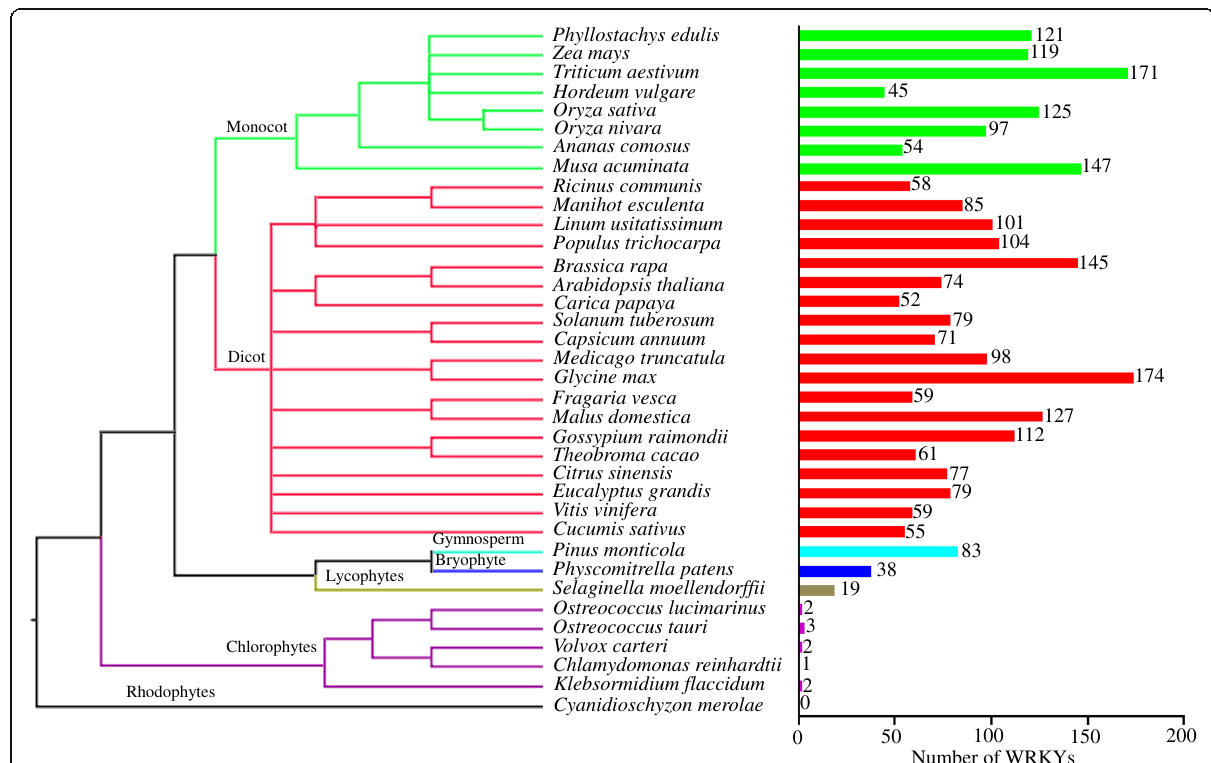
Fig. 2 Distribution of WRKY family genes in 36 plantae species. Phylogenetic tree was constructed based on NCBI taxonomy browser (https:// www.ncbi.nlm.nih.gov/Taxonomy/CommonTree/wwwcmt.cgi) and FigTree_v1.4.3 using Cyanidioschyzon merolae as an outgroup. The number of WRKYs on the right (for references see Additional file 1: Table S1). The expansion of WRKY family genes is mainly due to whole